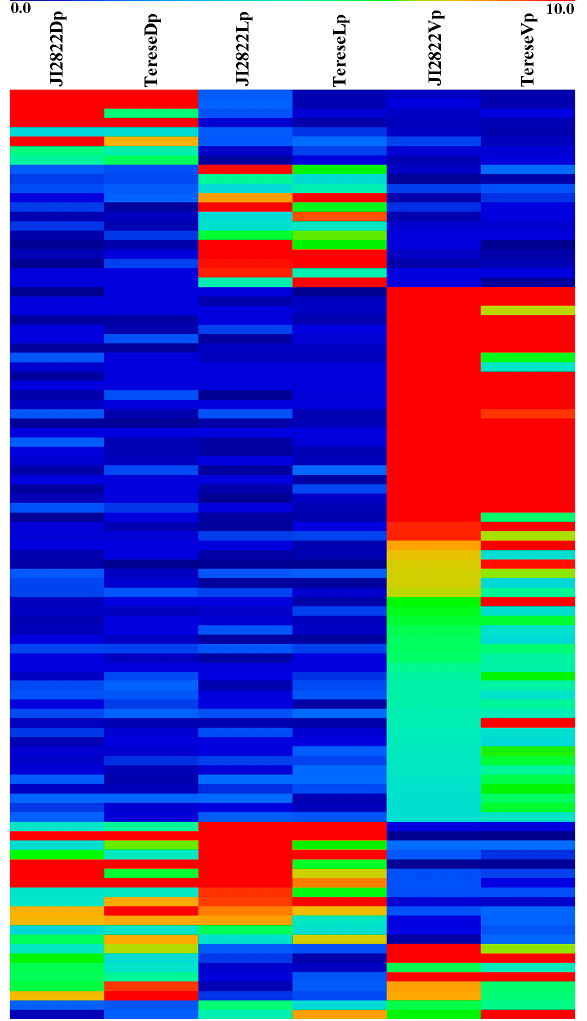
Figure 3. A heat map showing the expression patterns of DEGs in three types of petals. Dp, dorsal petals; Lp, lateral petals; Vp, ventral petals.